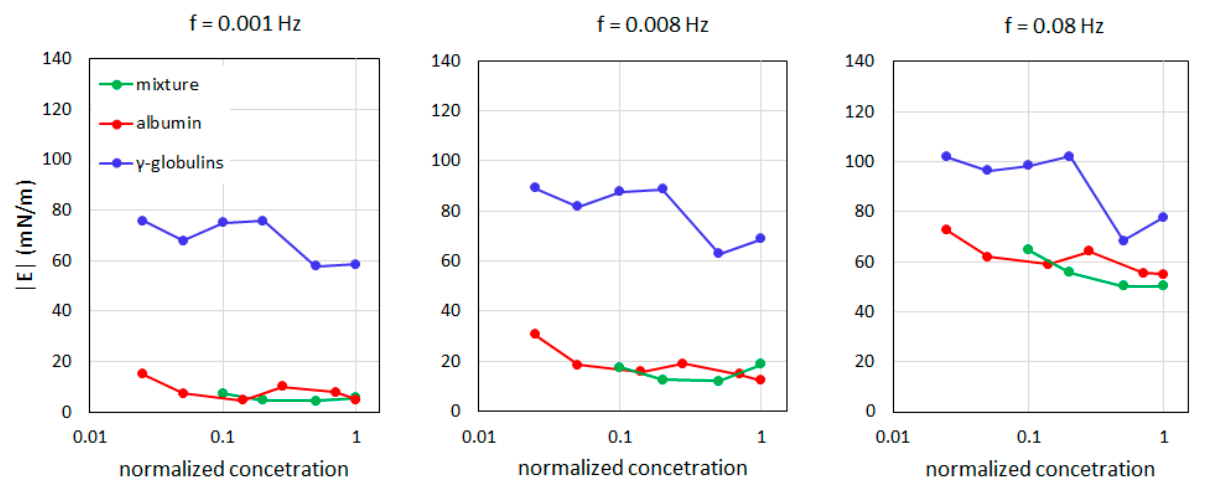
Figure 7. The surface dilational visco-elasticity modulus |E| values as a function of the protein concentration, expressed as a fraction of the physiological content in the blood according to Nepita et al. [3].